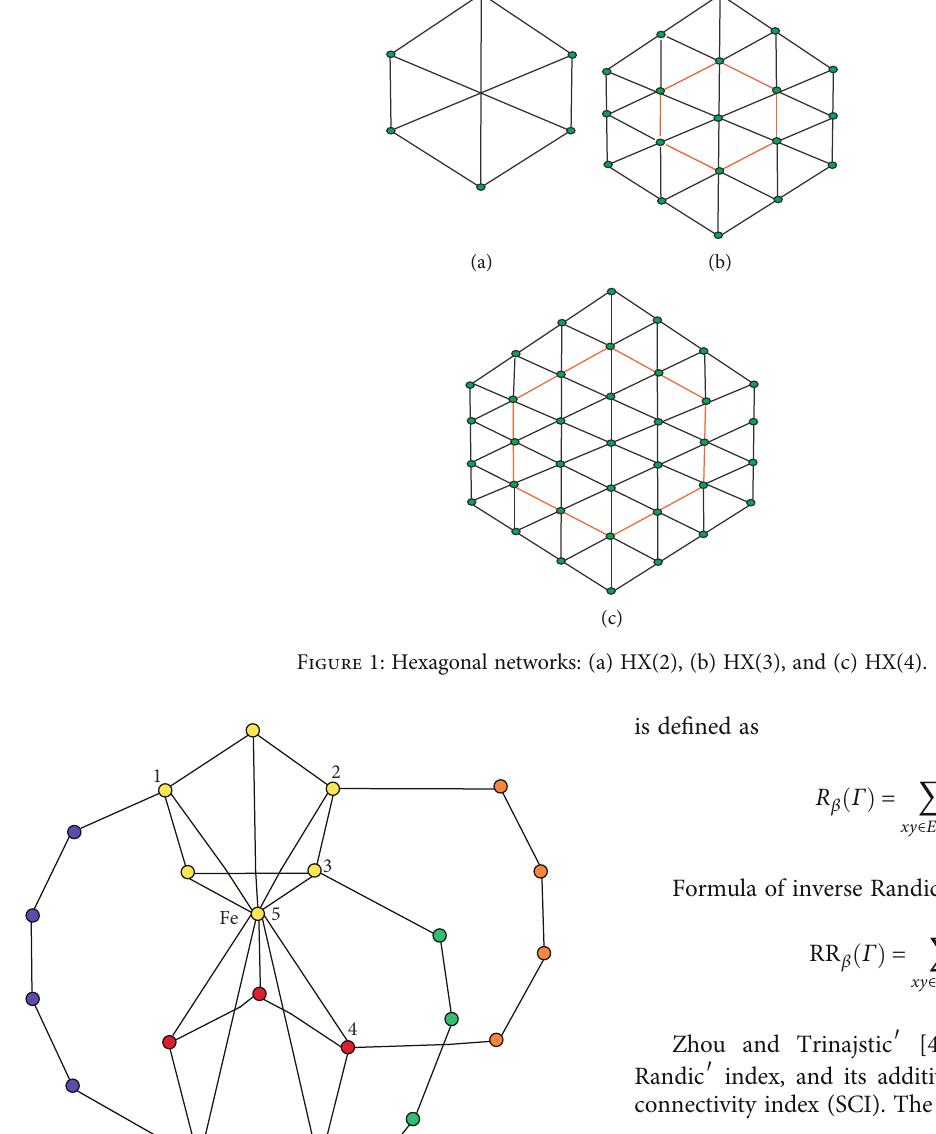
5 inside ferrocenophane molecular